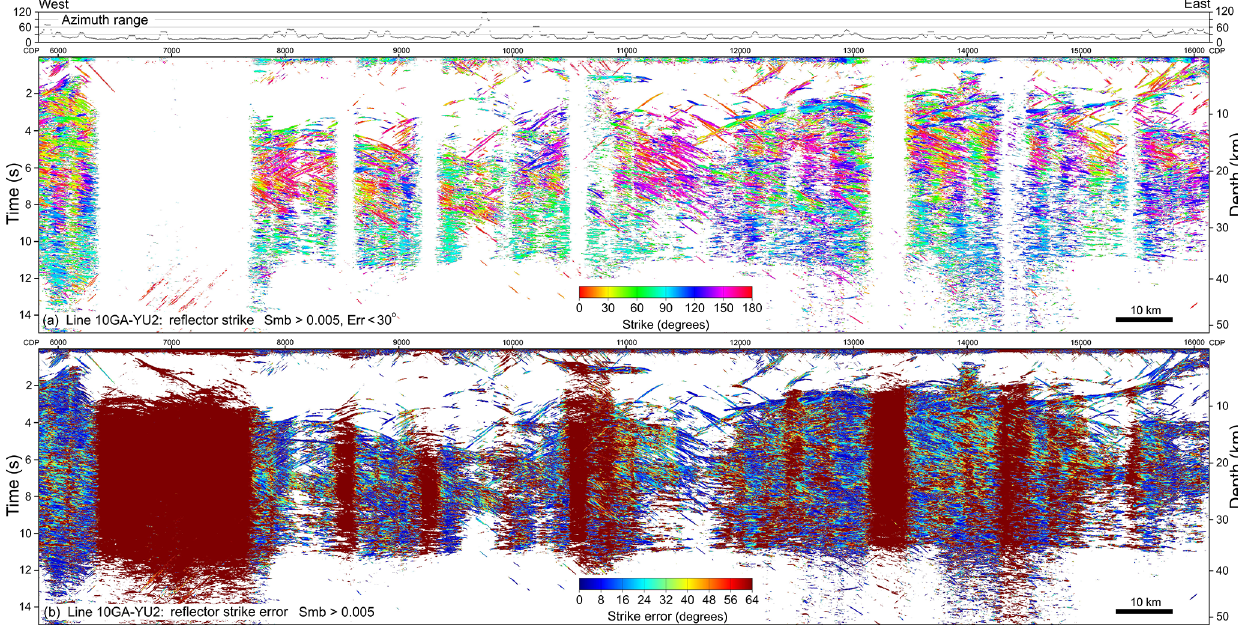
Figure 2. (a) Unmigrated reflector strike estimated for line 10GA-YU2. The range of source-receiver azimuths available for the orientation analysis is indicated in degrees in the overlying panel. Vertical white bands correspond to unreliable values that have been excluded due to low reflection semblance or high angular uncertainty. (b) Relative error in estimated strike, i.e. the range of angles within 90% of the global semblance maximum.